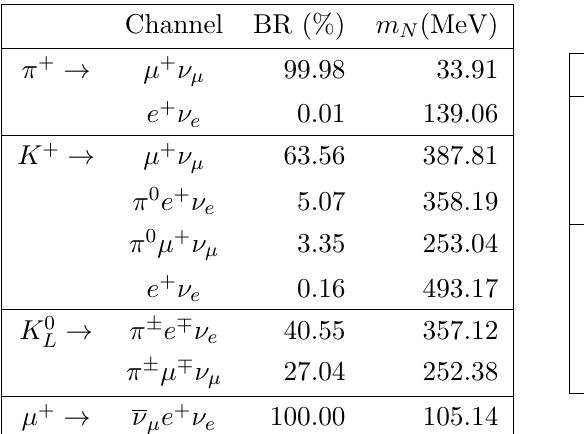
decay chain are s